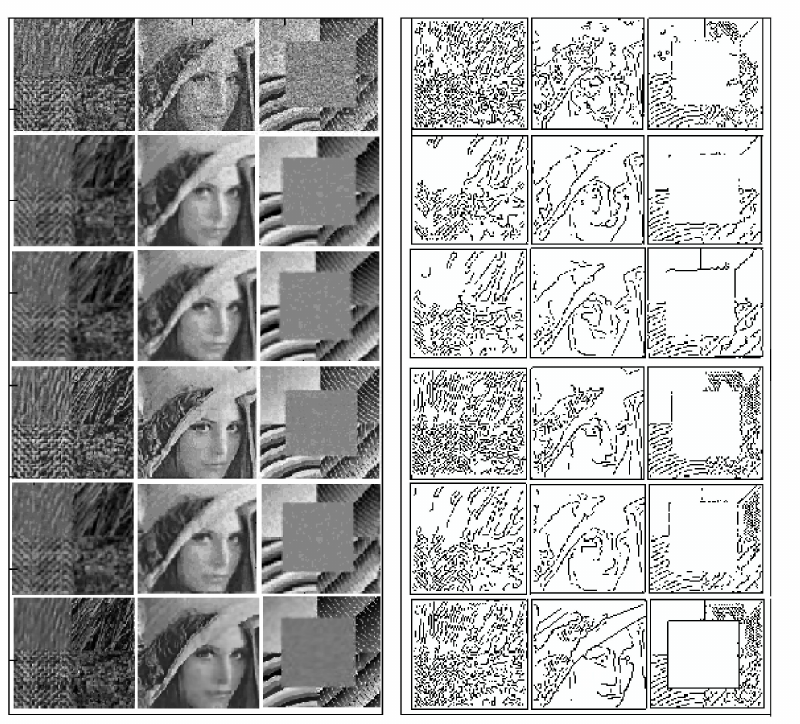
Figure 6. Results of different despeckling methods applied to a test image [40]—left column and the corresponding edge maps obtained with the Canny’s edge detector (right column). First line: the test image; second line: Lee despeckling method; third line: Kuan despeckling method; fourth line: MBD algorithm; fifth line: Frost despeckling method and last line: proposed despeckling